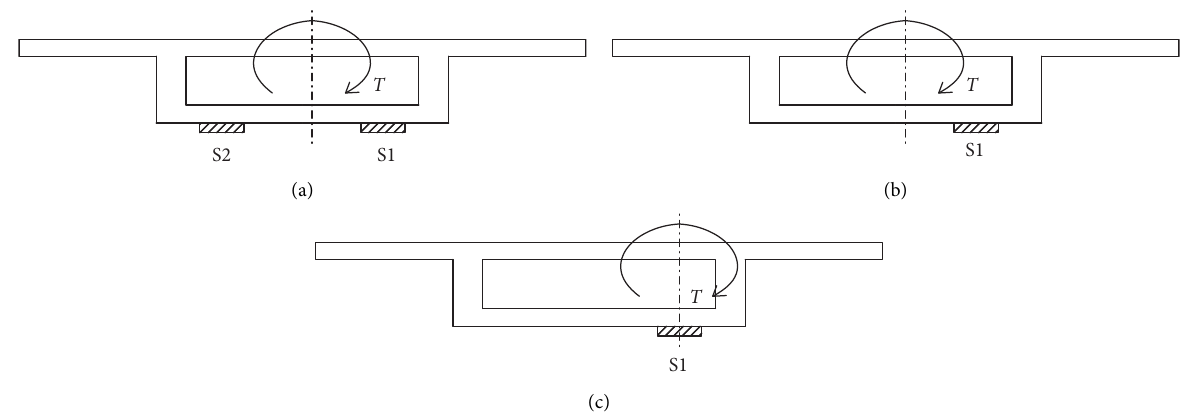
Figure 10: Torsion resistance system at the end bearing section in the models. (a) Before the disengagement of S2: deformable-body rotation mechanism in the beam and solid models. (b) After the disengagement of S2: deformable-body rotation mechanism in the beam model. (c) After the disengagement of S2: rigid-body rotation mechanism in the solid model.